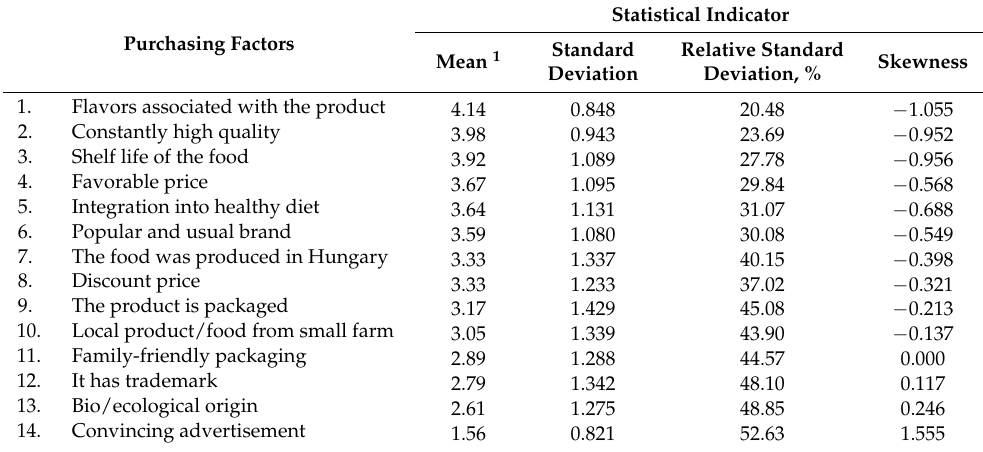
Table 4. Importance of purchasing factors when buying food during coronavirus (N =